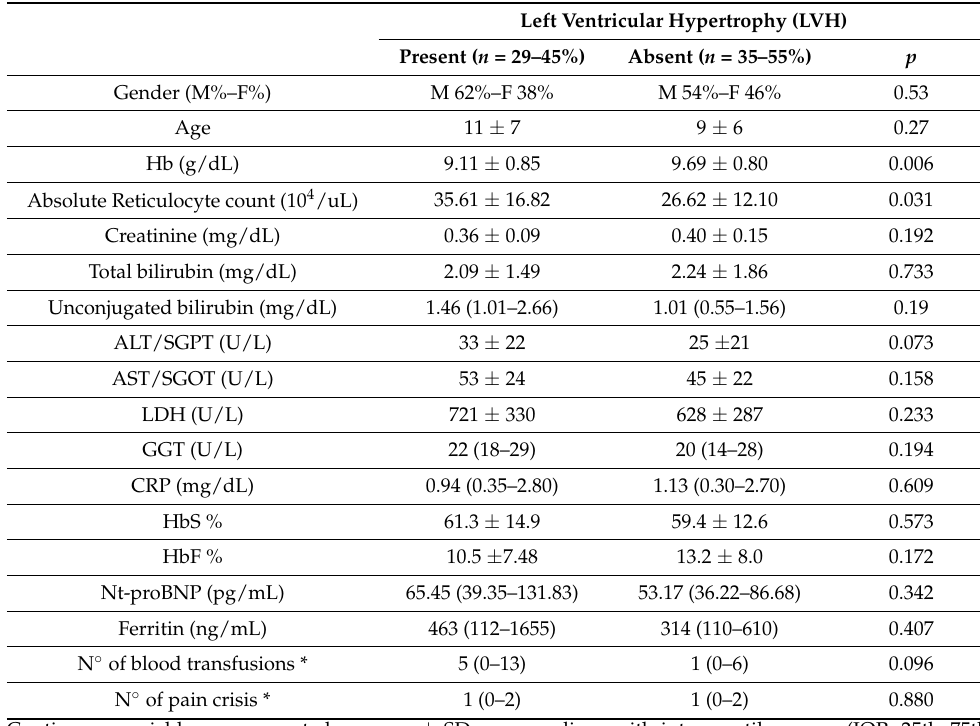
Table 4. Clinical and laboratory data of study groups based on the presence of